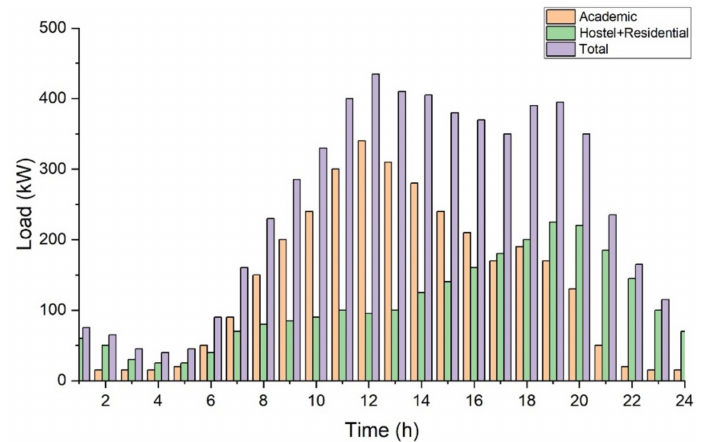
Figure 4. Daily average electrical load distribution